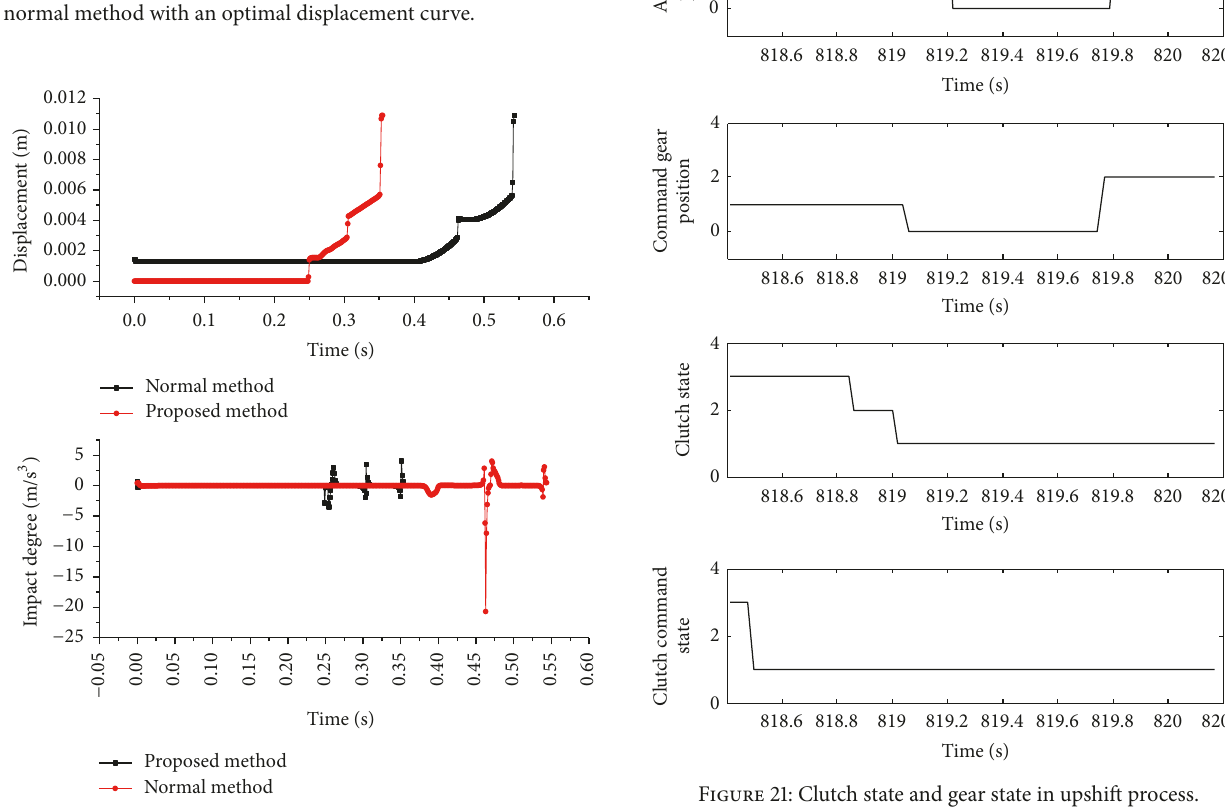
Figure 19: The results of the proposed method and normal method with a constant force.